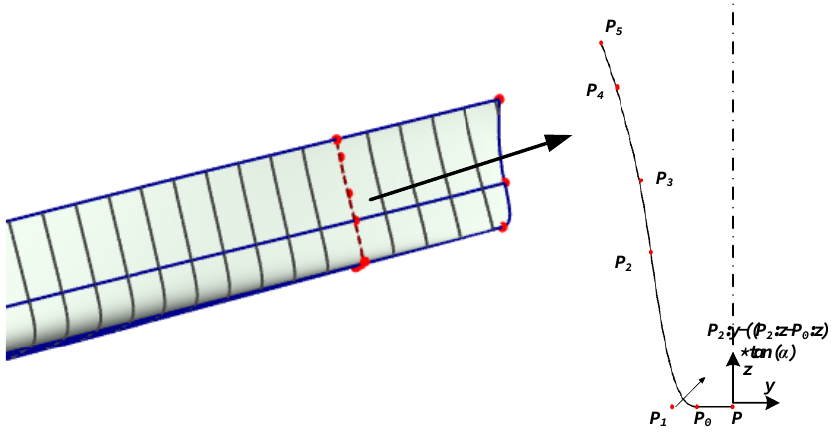
Figure 14. Schematic diagram of the curve cross-section at position X i = 2.8 m.